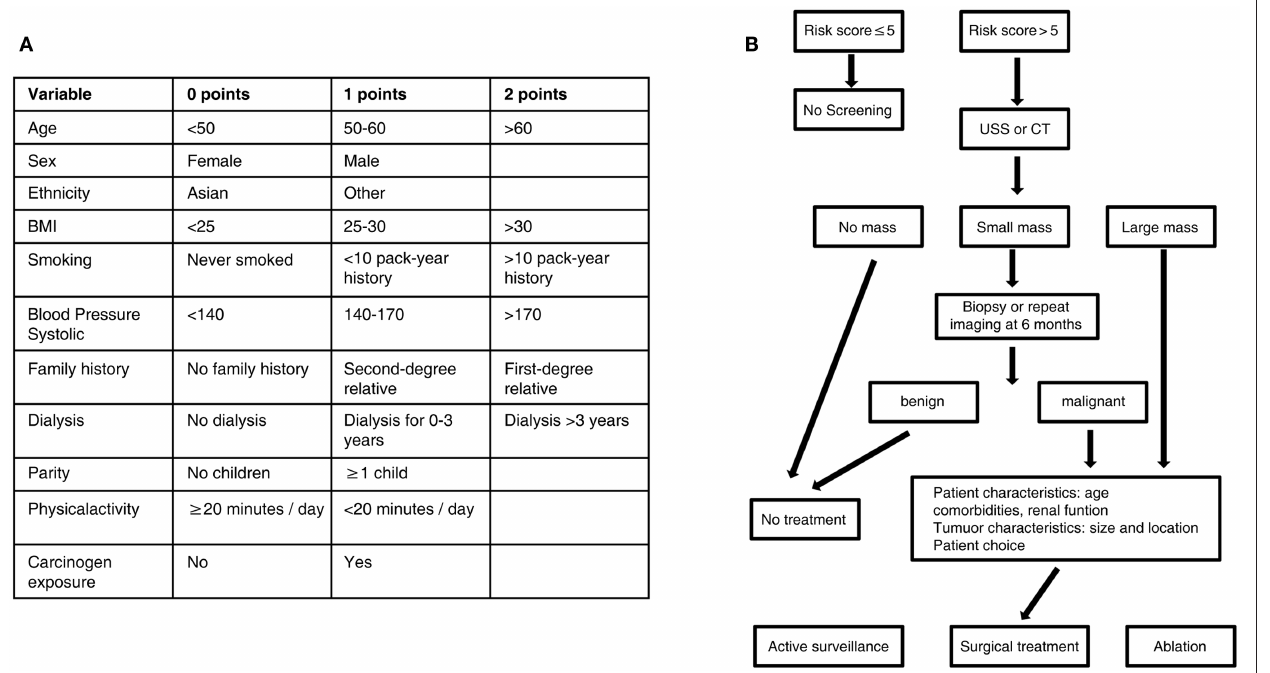
scan before treatement, while a large mass identified on screening leads directly to treatment. Treatment of identified masses will be influenced by patient comorbidities and patient choice; options include active surveillance, surgical excision, or ablation of the mass. USS, ultrasound scan; CT, computed